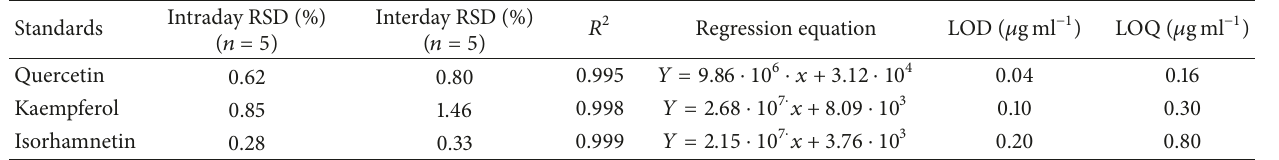
Table 2: Analytical characteristics of the HPLC method validation